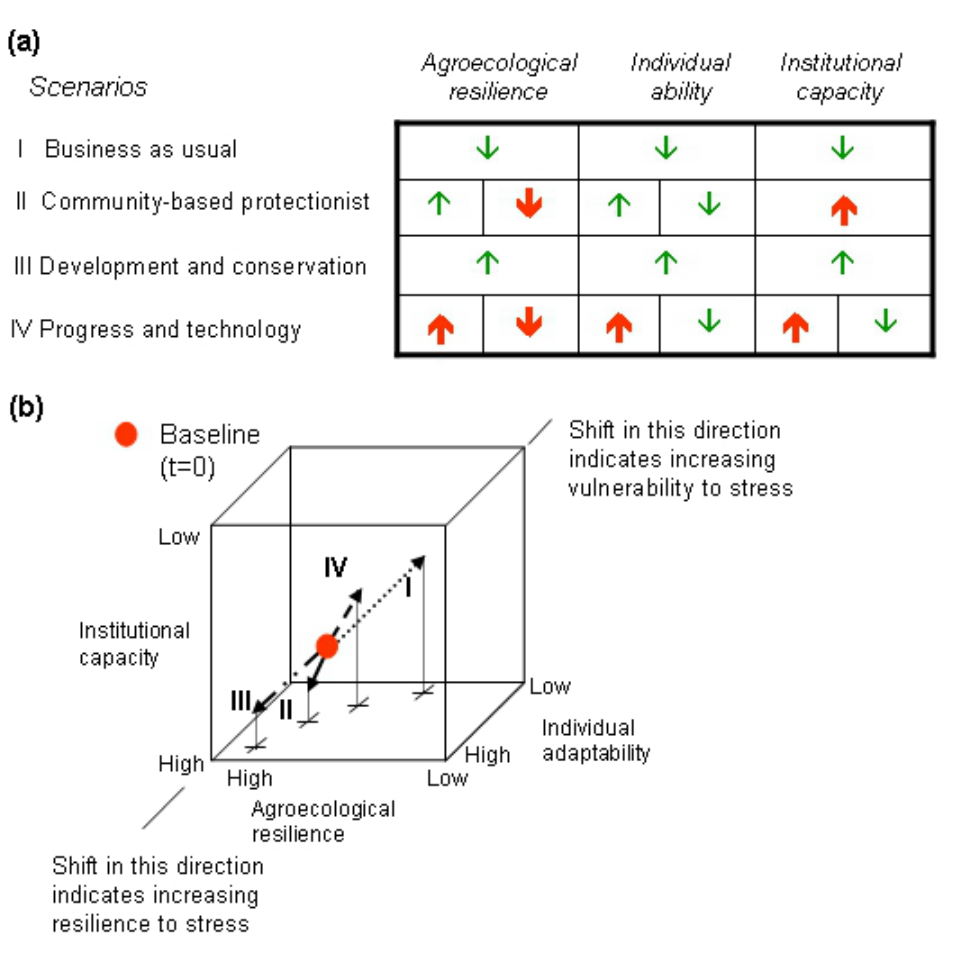
Fig. 5. (a) Heuristic illustration of trends of vulnerability indicators within the four scenarios, and (b) 3D space representation of the resulting hypothetical pathways from the actual baseline (t=0) to 2030 (adapted from Fraser